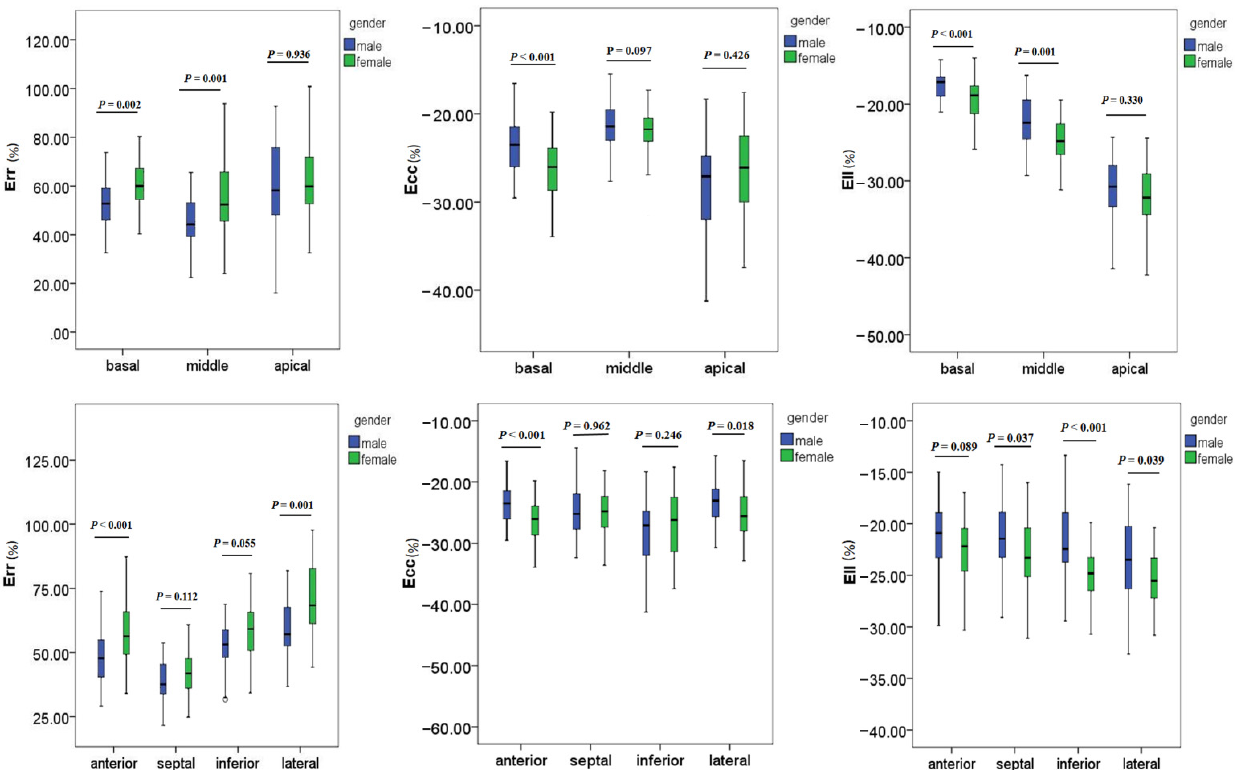
Figure 4. The boxplots for myocardial strain on the level and region of the left ventricular in different genders. The center box of the boxplots indicates the values from the lower quartile to the higher quartile. The center line shows the median. The range of whiskers is from the minimum to the maximum value. Err: radial strain; Ecc: circumferential strain; Ell: longitudinal strain. The correlation between left ventricular myocardial strains, age, and BMI is shown in Figure 5. GRS was significantly positively correlated with age (r = 0.219, p < 0.05). While GCS and GLS were negatively correlated with age respectively (r = − 0.127, p = 0.242; r = − 0.209, p = 0.052). GCS and GLS were significantly positively correlated with BMI respec- tively (r = 0.274, p < 0.05; r = 0.223, p < 0.05). In addition, LVEDV and LVESV were nega- tively correlated with age (r = − 0.222, p < 0.05; r = − 0.274, p < 0.05), respectively. There was no significant difference in the GRS, GCS, and GLS among all age groups (Figure 6).